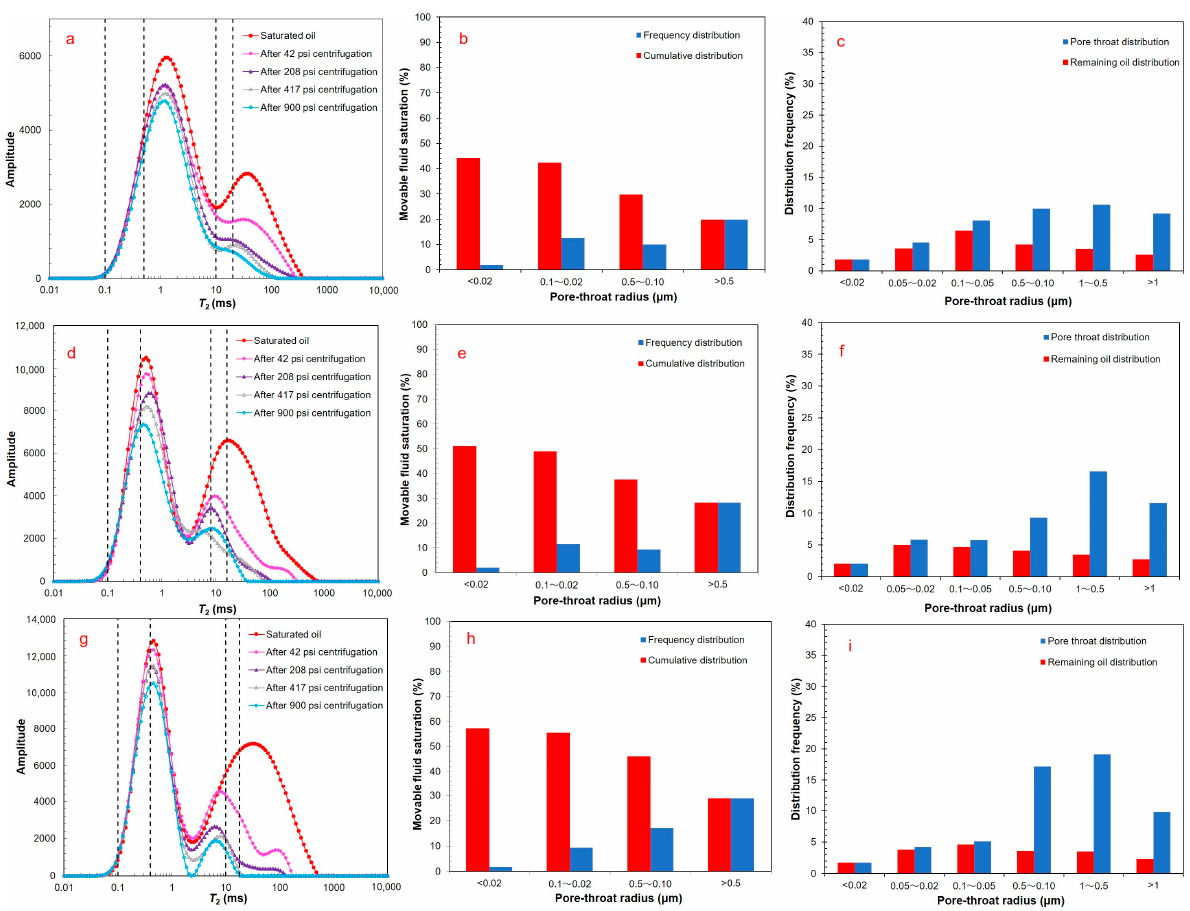
Figure 7. Centrifugal NMR results of core samples of type Ⅱ reservoir; ( a , d , g ) are the T 2 spectrum of centrifugal NMR of CD-2, CD-5 and CD-7, respectively; ( b , e , h ) are the throat radius distribution frequency diagram of CD-2, CD-5 and CD-7, respectively; ( c , f , i ) are the frequency distribution of residual oil in pore space of different scales of CD-2, CD-5 and CD-7, respectively. CD-1, CD-6 and CD-8 belong to the type III reservoirs. The T 2 spectrum of the type III reservoirs show a bimodal distribution in the saturated oil state. The peak on the right is not obvious, indicating few large pore throats (Figure 8a,d,g). The T 2 cutoff values of the effective pore, movable fluid pore and movable crude oil pore are 0.7 ms, 10.0 ms and 20.0 ms, respectively. For the type III reservoir, the distribution frequencies of pore throat radii >0.1 μ m, 0.1–0.02 μ m and <0.02 μ m are 19.5%, 6.6% and 0.82%, respectively (Figure 8b,e,h). The average production degree of crude oil in the pore throats with a radius greater than 0.1 μ m is 73.5% and that of 0.02–0.1 μ m is 9.7%, which is the main occurrence space of the remaining oil. For crude oil in pore throats with radius less than 0.02 μ m, the degree of crude oil production is 0% (Figure 8c,f,i).